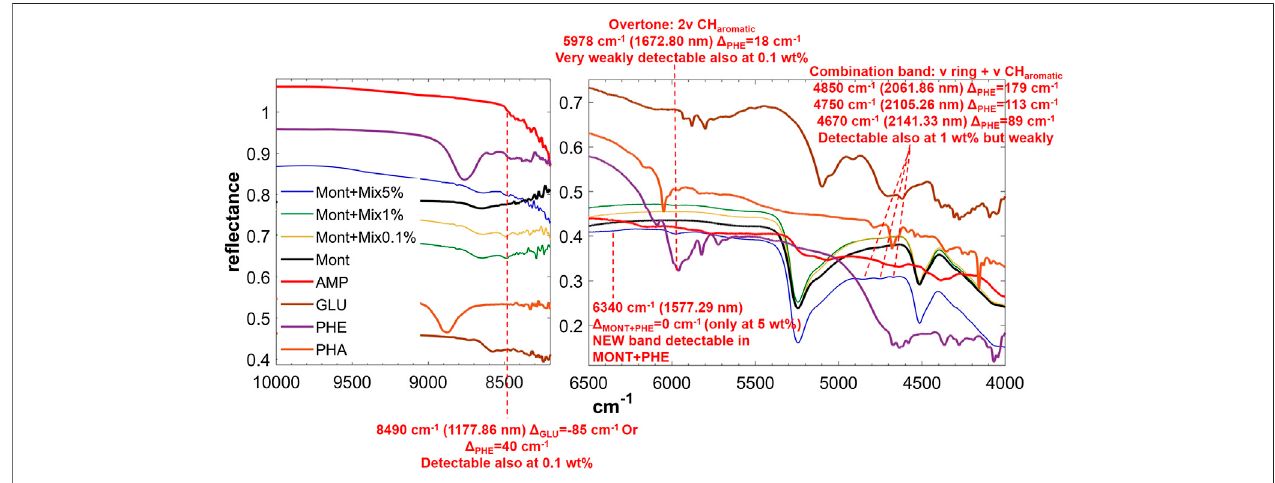
FIGURE7| NIR spectraofMIXadsorbedon montmorillonite at 5,1,and 0.1 wt%concentration. Legend: Δ PHE (cid:2) wavenumber shiftwithrespect tothesame peak of the pure molecule in the solid state; Δ MONT+PHE (cid:2) wavenumber shift with respect to the same peak of PHE adsorbed on MONT; ν (cid:2) stretching vibrational mode.